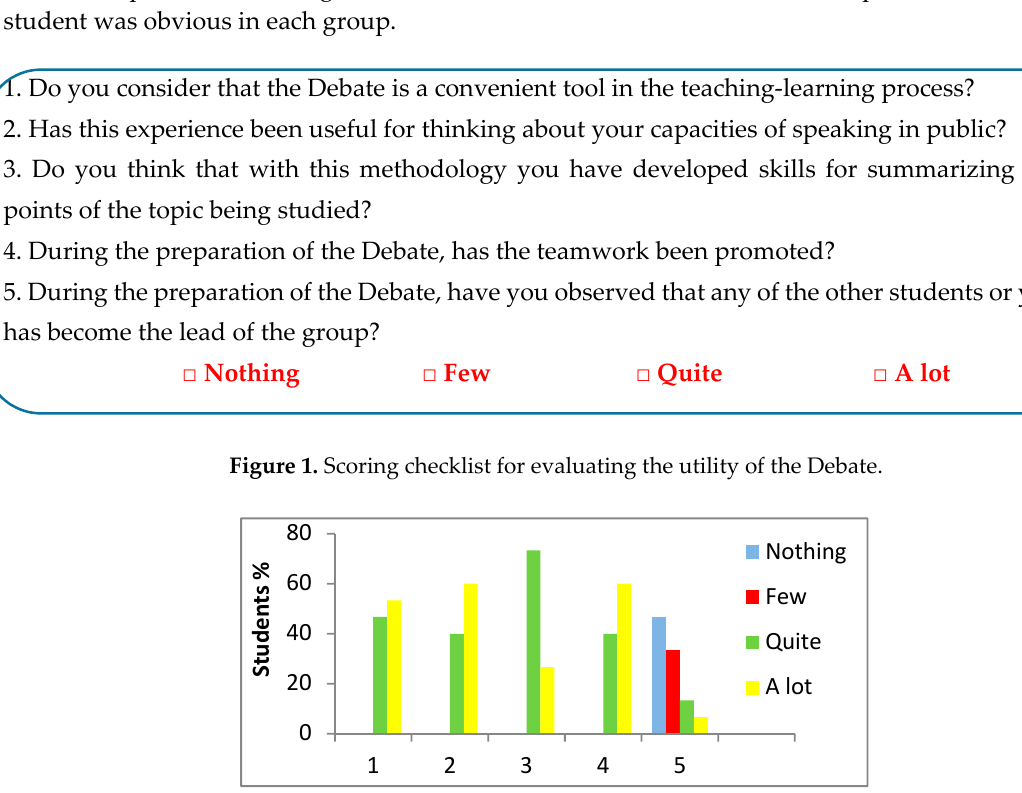
Figure 2. Students’ answers to following questions: 1. Useful as teaching-learning tool? 2. Good